Question: In one sentence, what is this figure communicating?
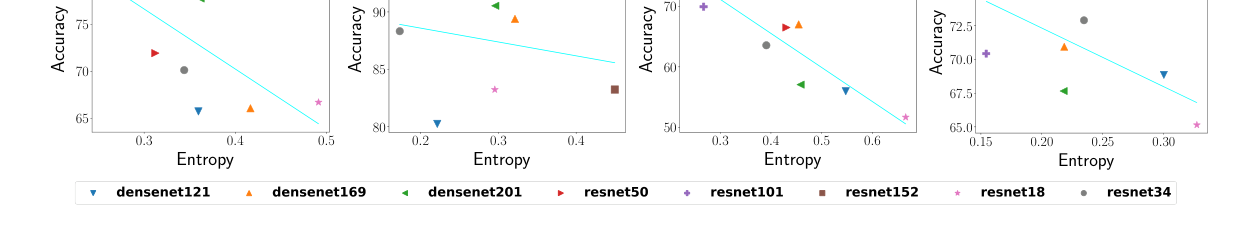
Answer: (Best viewed in color.) The superiority of TETOT (top row) in achieving a high (negative) correlation (ρ in the plot titles) with transferability compared to prediction entropy (bottom row) for selecting the best model architecture for making predictions on a given target domain at test time. Models are trained using Cartoon (C) as the source domain (in the single domain setting) and Art (A), Photos (P), and Sketch (S) (in a multi-domain setting) from PACS and evaluated on various target domains.